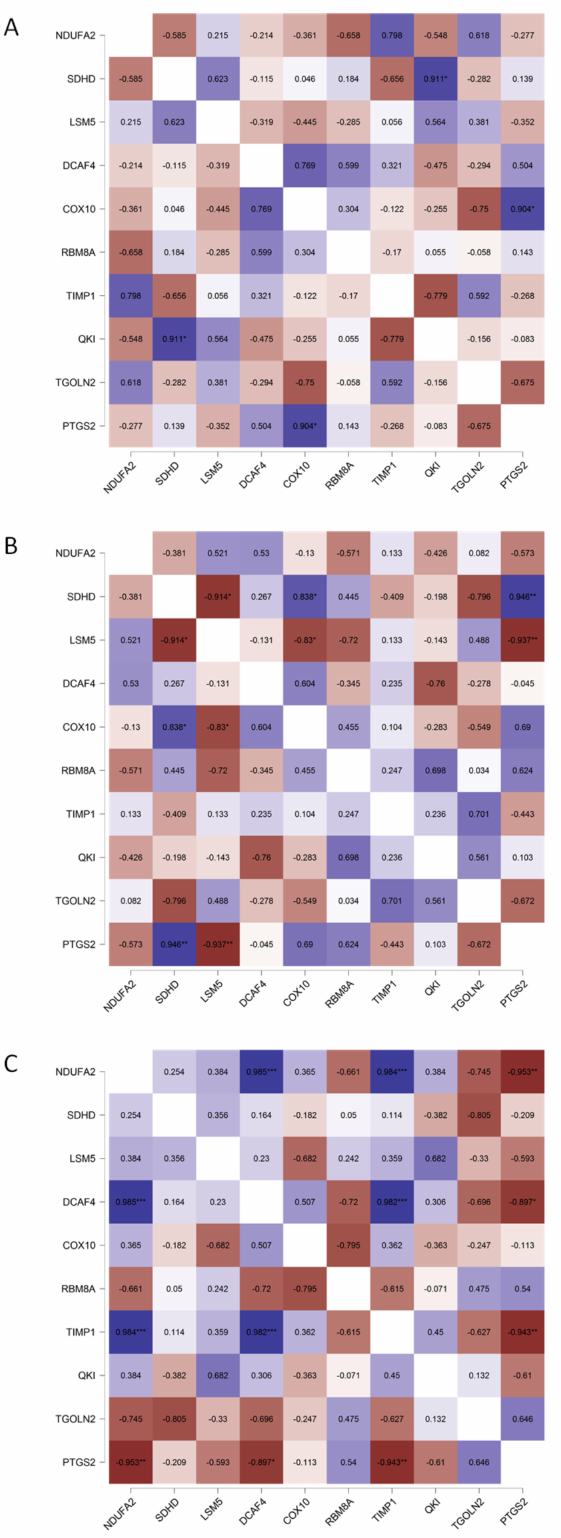
Figure 6. Pearson correlation matrix of FOLFIRI-resistance-related top networking DEGs. mRNA expression data of parental and corresponding resistant variants of CRC cell lines (GSE42387) ( A ) HT- 29, ( B ) HTC116, and ( C ) LoVo were pooled to create a Pearson correlation matrix using JASP 0.14.1.0 software; * p < 0.05, ** p < 0.005, and *** p <